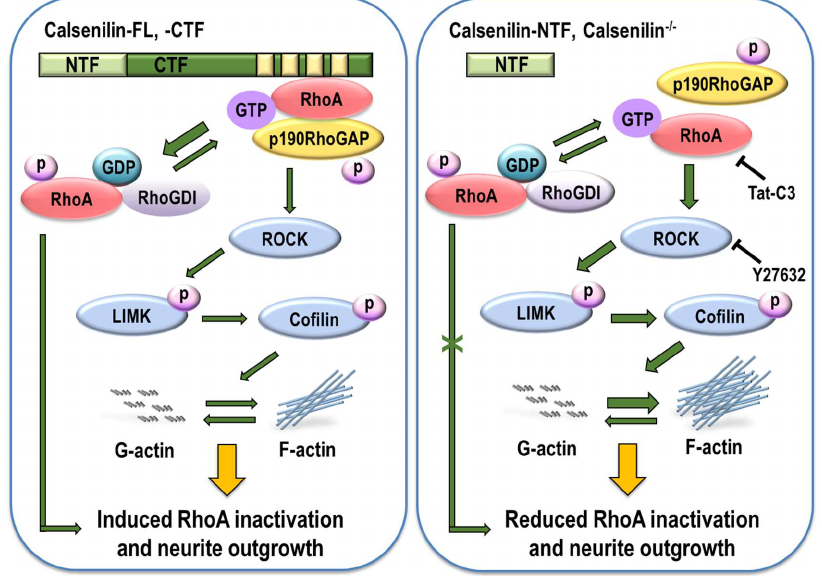
Figure 8. Overexpression of calsenilin-FL and -CTF enhanced RhoA inactivation and neurite outgrowth. In calsenilin-FL and -CTF expressing cells, calsenilin increased the phosphorylation of RhoA, enhancing the interaction between RhoA and p190RhoGAP. This complex led to the inactivation of RhoA and its downstream effector proteins. Subsequently, RhoA inactivation decreased actin polymerization and increased neurite outgrowth. In contrast, depletion of calsenilin prevented RhoA inactivation and neurite outgrowth by interfering with the